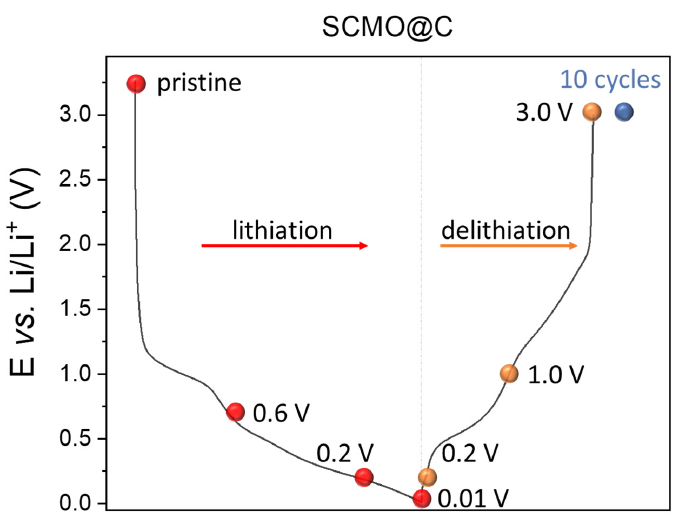
Figure 6. Dis-/charge profile of SCMO@C-based electrodes in half-cell configuration with an indica- tion of the different cut-off potentials for the ex situ XAS investigation. The X-ray absorption near edge structure (XANES) spectra recorded at the different states of charge for the Sn L 3 − edge as well as the Co and Mn K − edge are presented in Figure 7. The spectra at the Sn L 3 − edge were collected in transmission mode and are di- vided into two panels, i.e., Figure 7a,b, for the sake of clarity. Figure 7a displays the evo- lution of the Sn L 3 − edge spectra during the first discharge, i.e., lithiation, while in Figure 7b the spectra recorded upon the first charge and after 10 cycles are presented (in both cases also the spectrum of the pristine electrode is provided for a direct comparison).